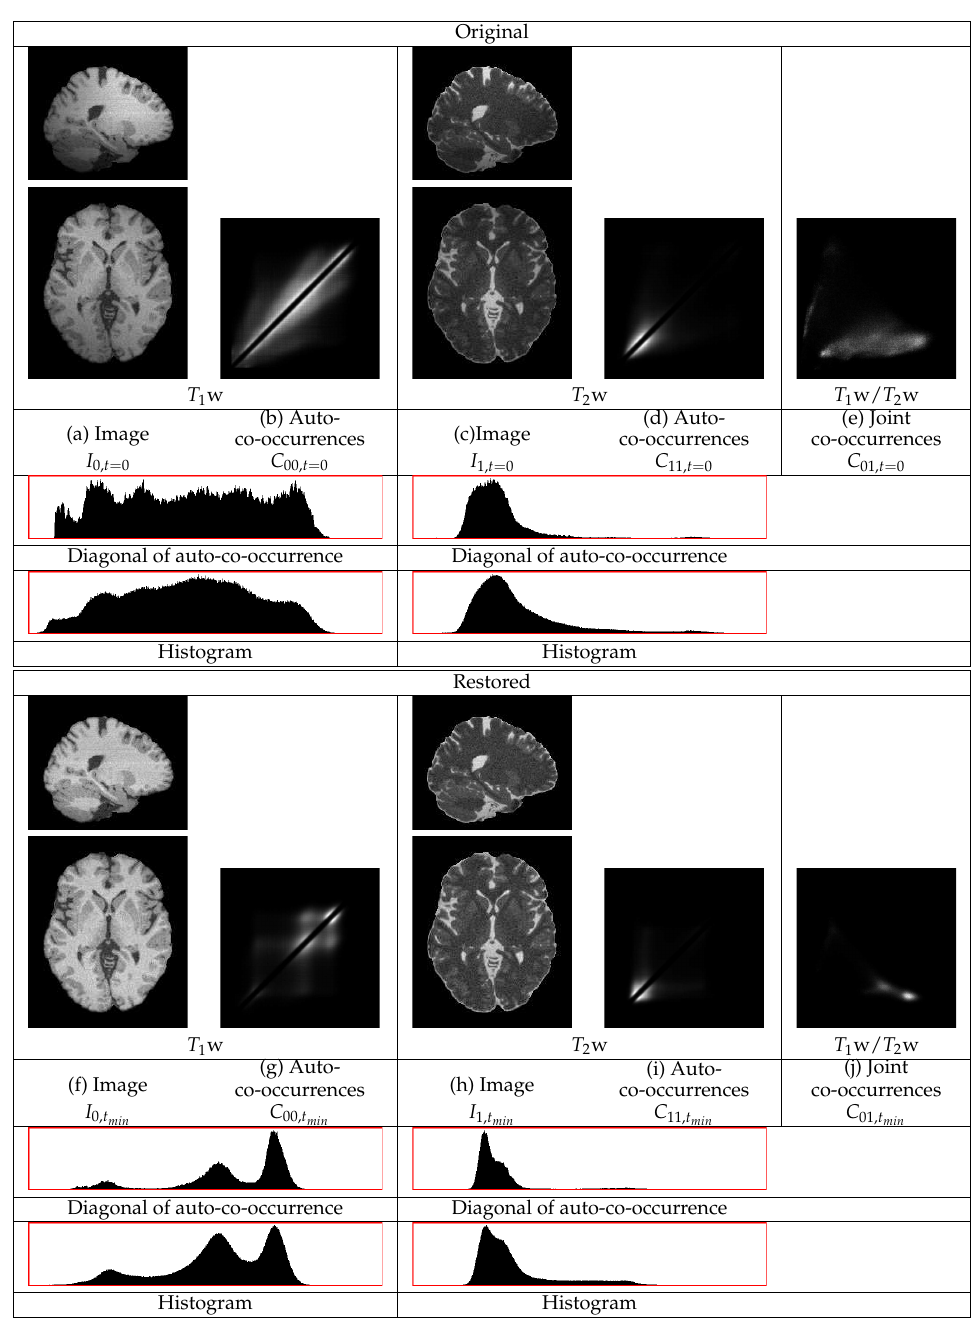
Figure 5. The restoration of a T 1 w and a T 2 w BrainWeb image pair with non-uniformity of 100% and noise of 5%. The restoration makes the cerebellum brighter and the statistics